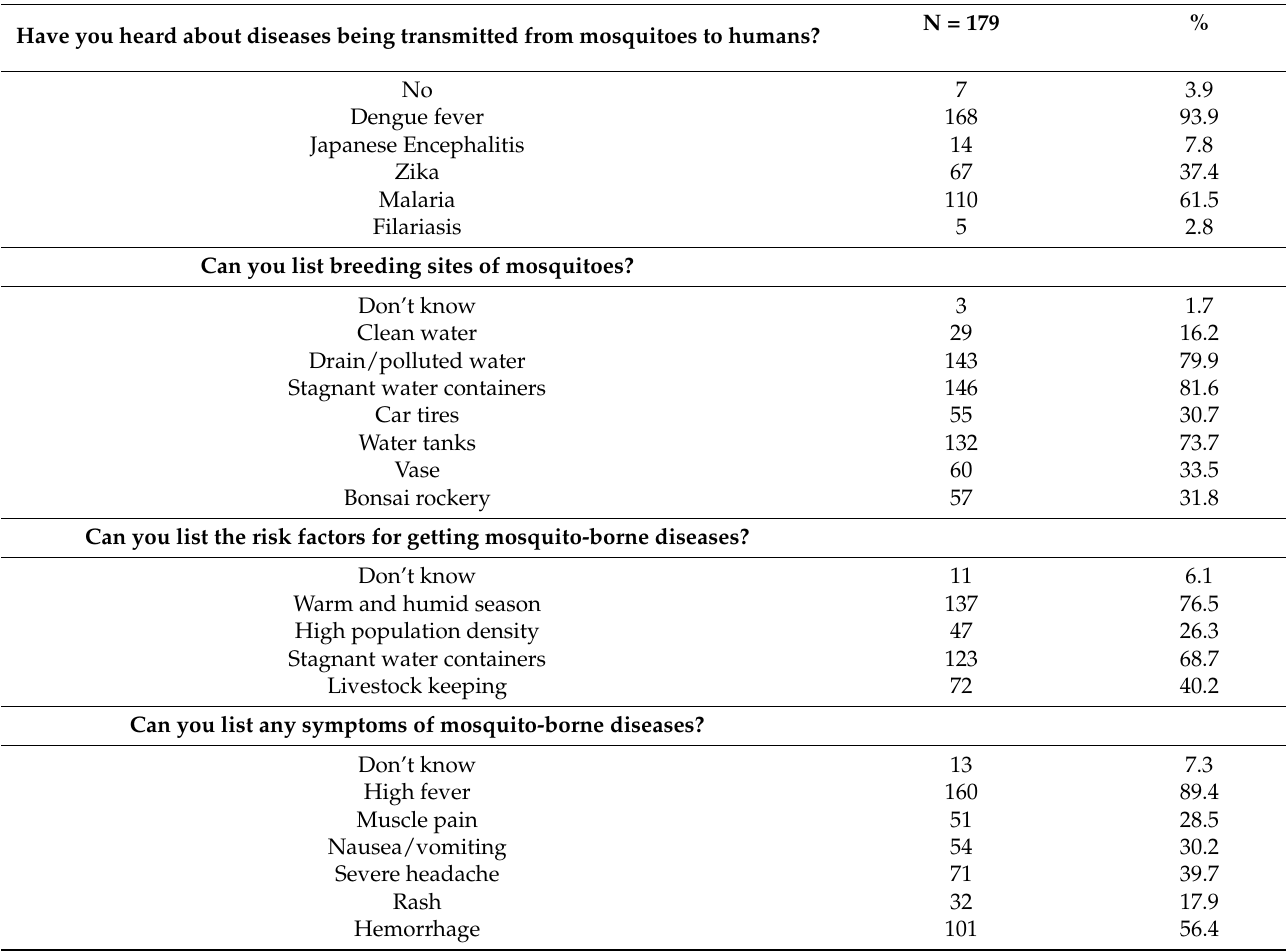
Table 2. Knowledge of pig farmers about mosquito-borne